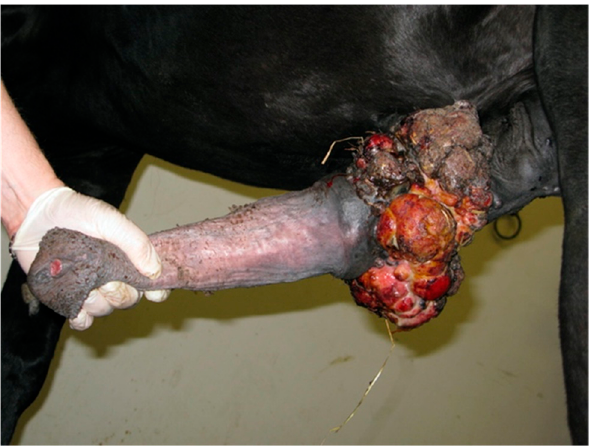
Figure 7. Appearance of the preputial mass after traction on the free portion of the penis (clinical case 3).